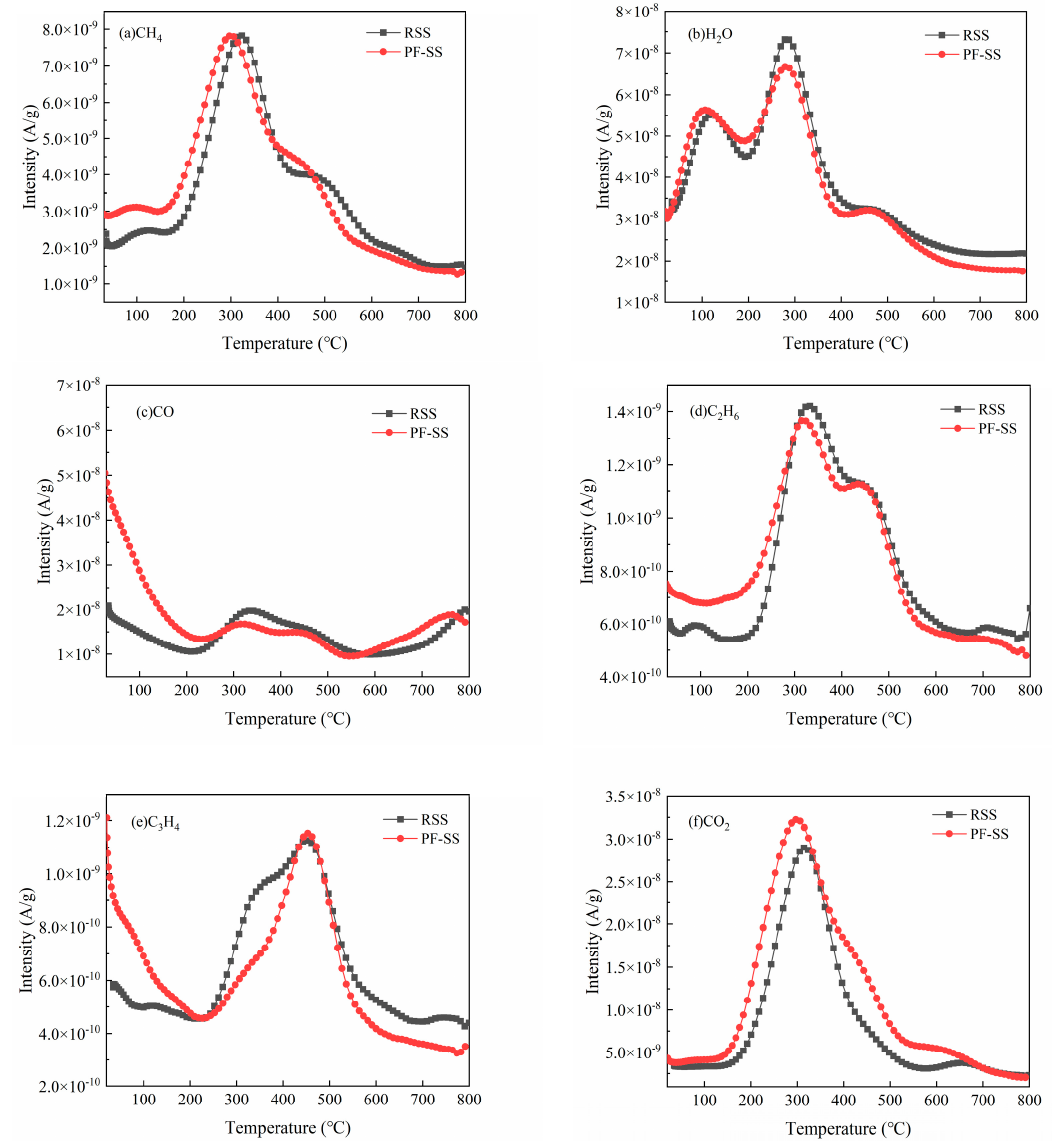
Figure 2. Main C/H/O-containing gas products released during the pyrolysis of sludge samples. ( a ) CH 4 ( b ) H 2 O ( c ) CO ( d ) C 2 H 6 ( e ) C 3 H 4 ( f ) CO 2 .